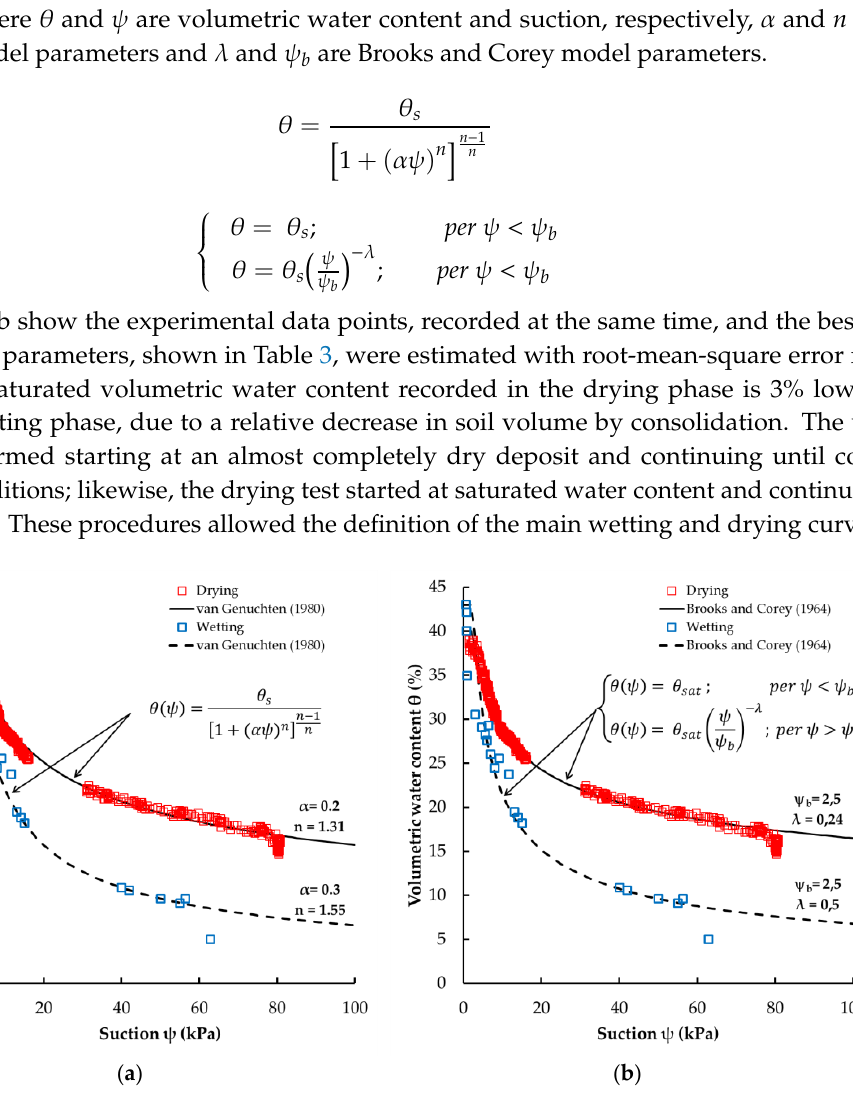
Figure 5. Wetting and drying water retention curves. ( a ) Van Genuchten model [19]. ( b ) Brooks and Corey model [17]. Table 3. Parameters of water retention curve models and root-mean-square error. Table 3. Parameters of water retention curve models and root-mean-square